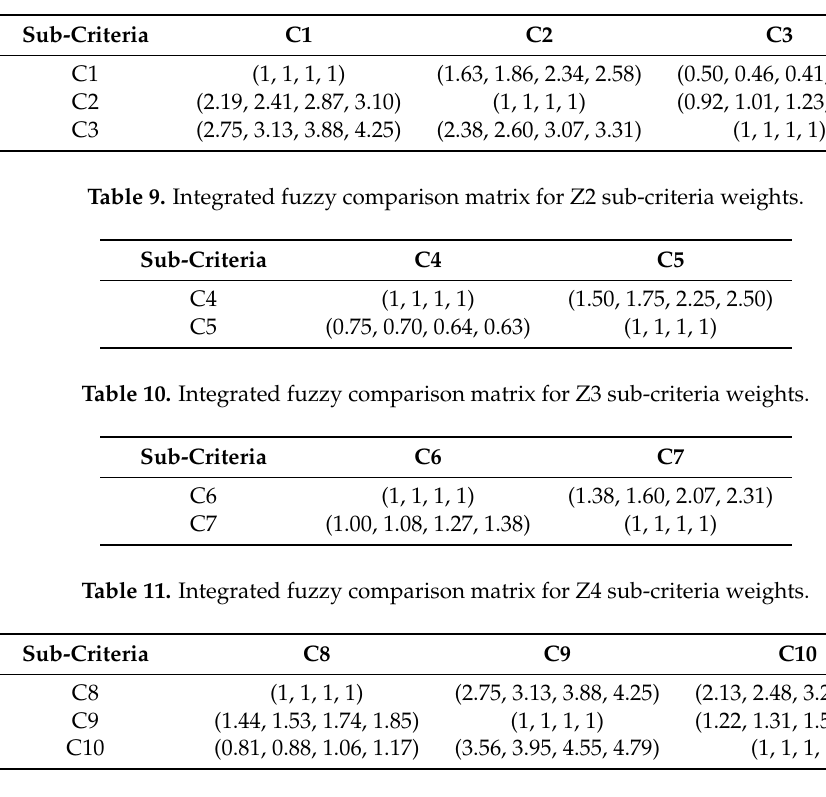
Table 8. Integrated fuzzy comparison matrix for Z1 sub-criteria weights.